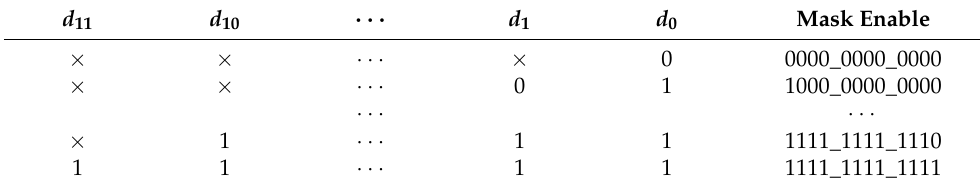
Figure 19. Hardware architecture of VCU. Table 2. Mask enable of VCU ( N = 36, p = 24, × : don’t care).